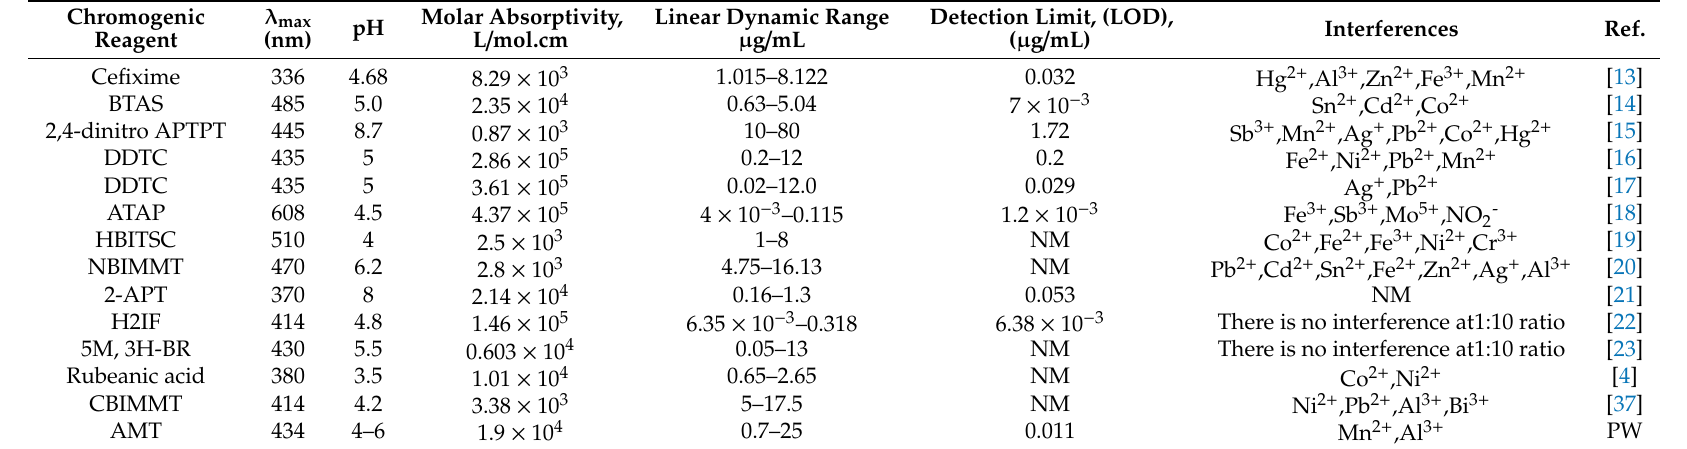
Table 5. Comparison between the proposed method and previously-published spectrophotometric methods to estimate Cu(II) *.